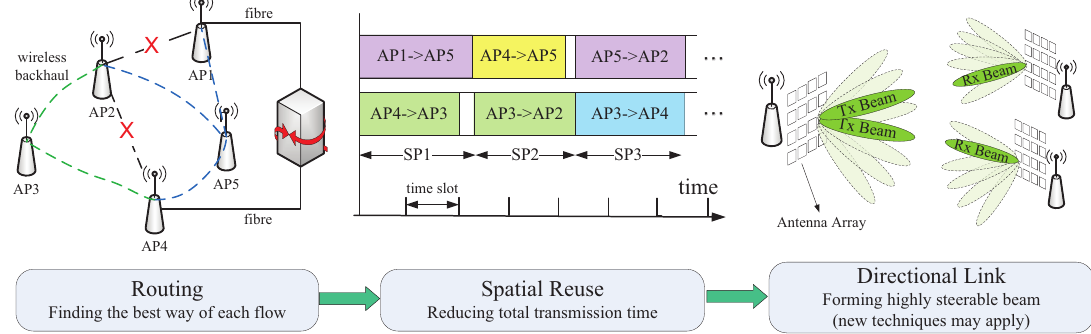
Figure 3. System framework for 5G mm-wave